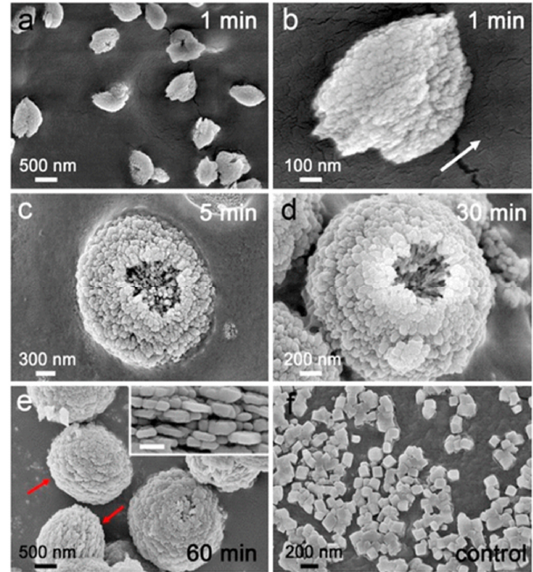
Figure 12. SEM images of CaCO 3 minerals on the surface of chitin. ( a ) Low and ( b ) high magnification of minerals obtained in 1 min of mineralization, ( c ) 5 min, ( d ) 30 min, ( e ) 60 min. ( e , inset) The equator of mineral. Scale bar in the inset is 200 nm. The equator of the minerals was pointed by red arrows. ( f ) Minerals obtained in the absence of protein. The figure is adapted with permission from [62].